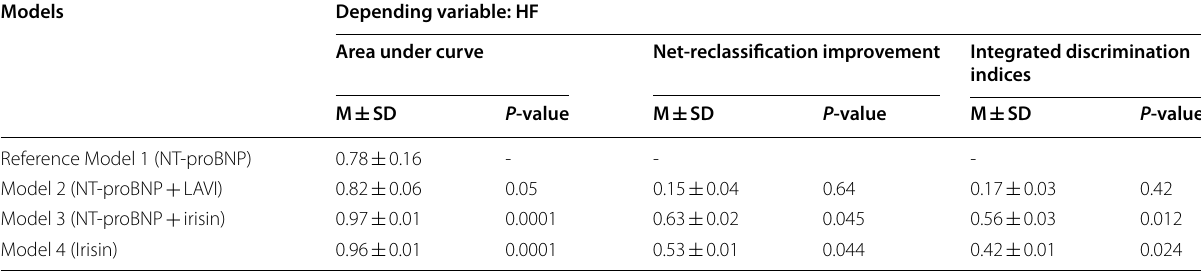
Table 4 The comparisons of predictive models for HF: The results of model fit